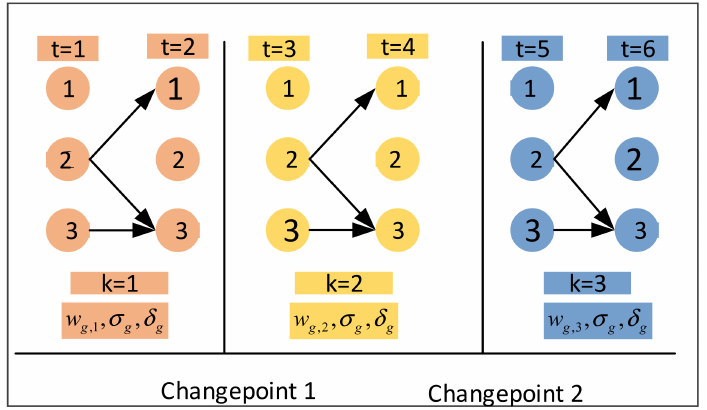
Figure 2. Example of a non-homogeneous dynamic Bayesian network with two changepoints.